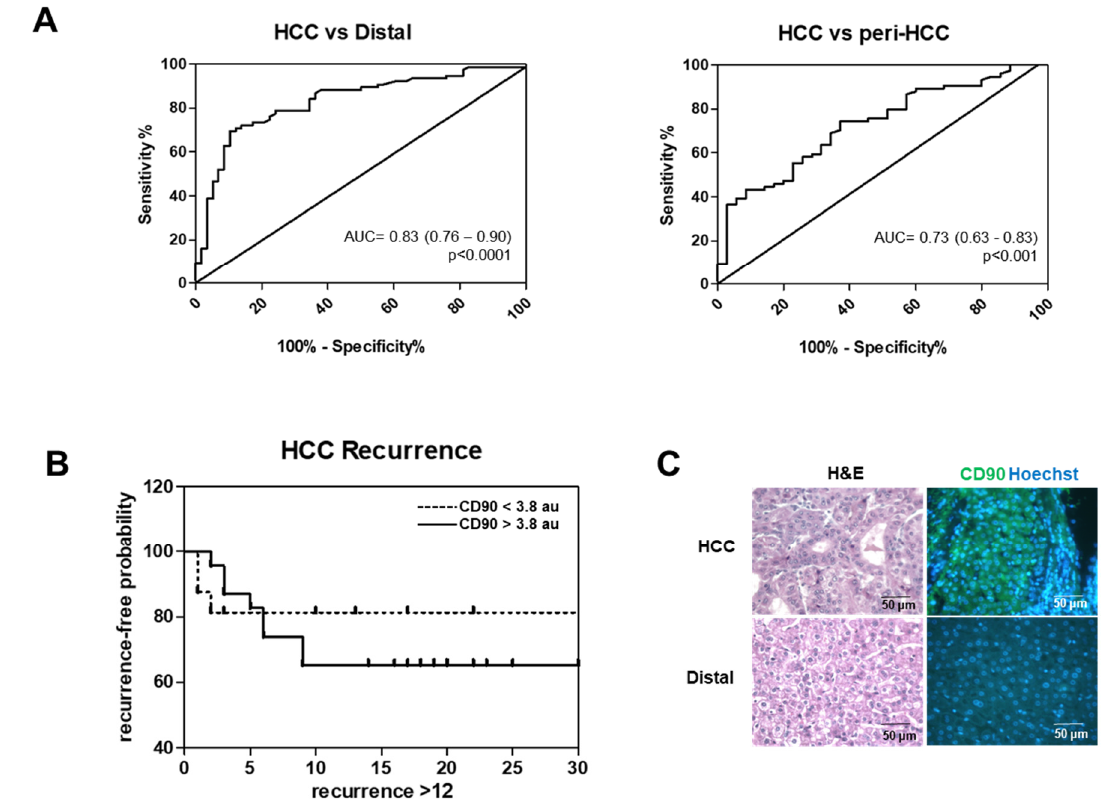
Figure 2. HCC CD90 mRNA expression for diagnostic and prognostic value. ( A ) Receiver operator characteristic (ROC) curve to distinguish HCC from distal (left) and peri-HCC (right) from Vietnamese and Italian cohorts. AUC = area under the curve. ( B ) Kaplan–Meier analysis of HCC recurrence in 12-months after hepatectomy. The graph represents 30-months of patient follow-ups. CD90 mRNA expression higher than 3.8 au is associated with a shorter recurrence time compared to lower expression. ( C ) Hematoxylin and Eosin (H&E) staining and immunofluorescence of CD90 in a representative paired HCC and distal tissue. CD90 protein is stained in green and the nucleus in blue. Magnification: objective 40X.